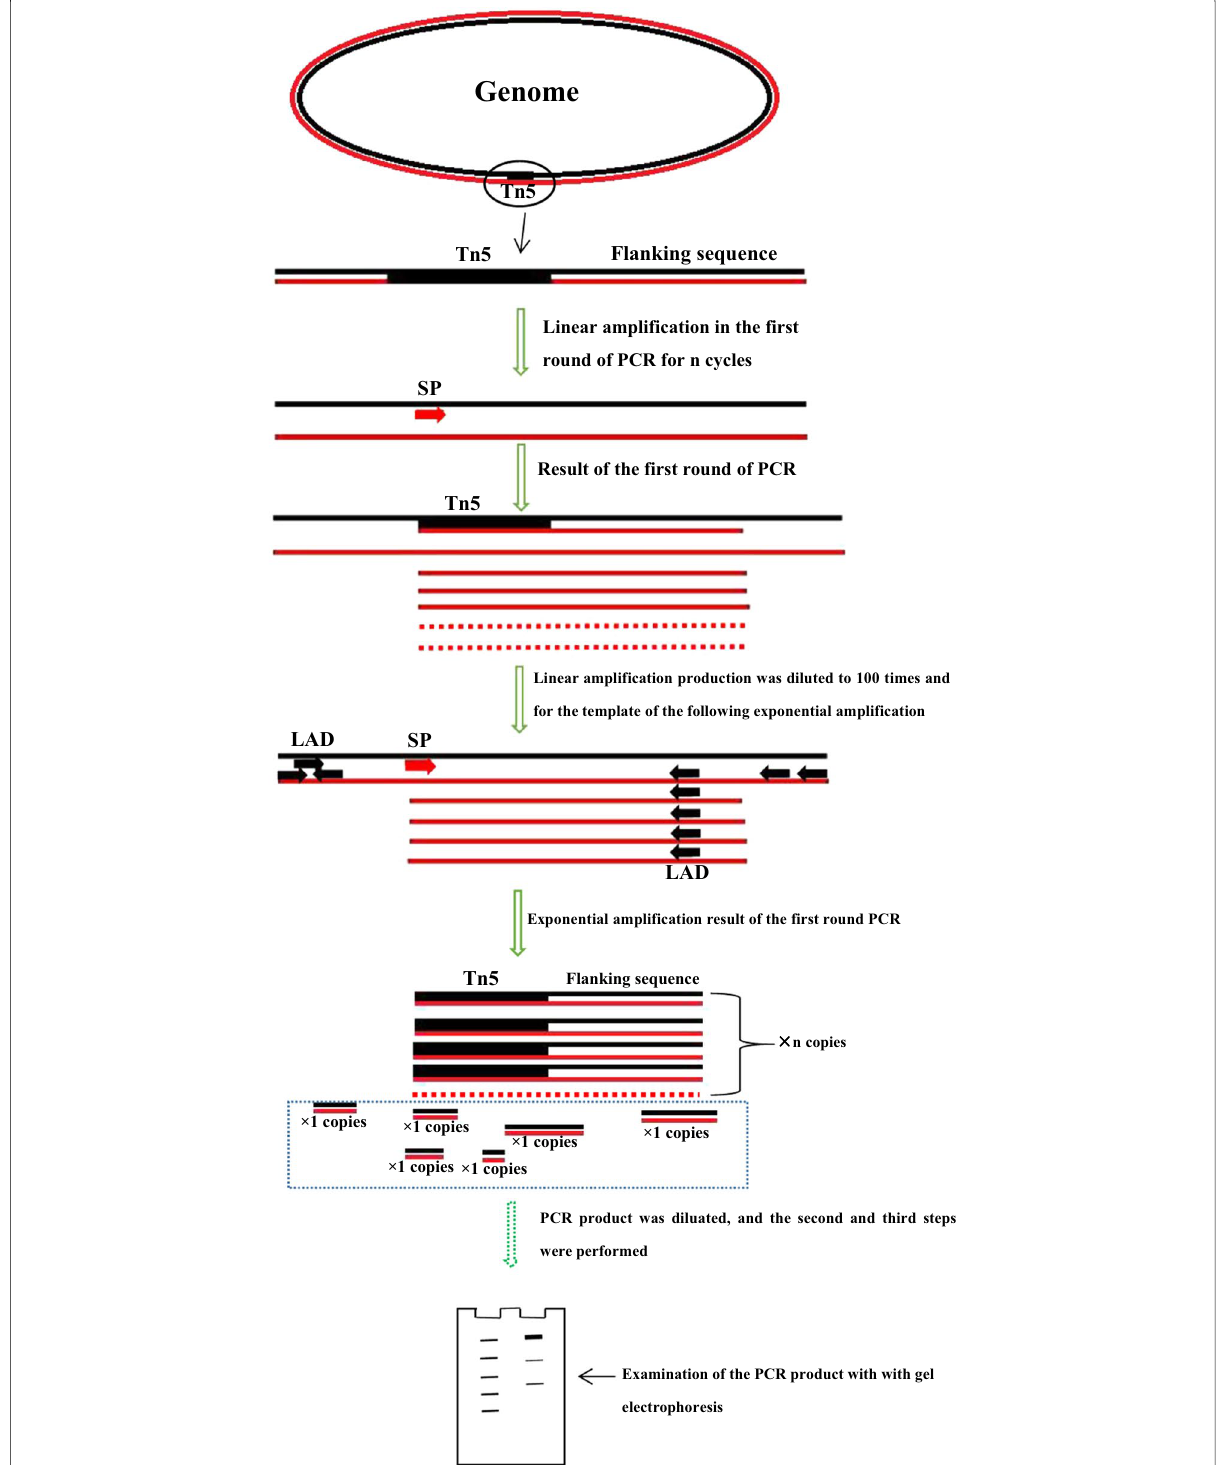
Fig. 1 The genome walking method scheme. Black lines represent the sense strand of the DNA, and red lines represent the anti-sense strand. Black shadow positions on the DNA represent the known sequence, and the residual white parts on the DNA represent unknown sequences. Red arrows (SP) represent specific primers. Black arrows (LAD) represent degenerate